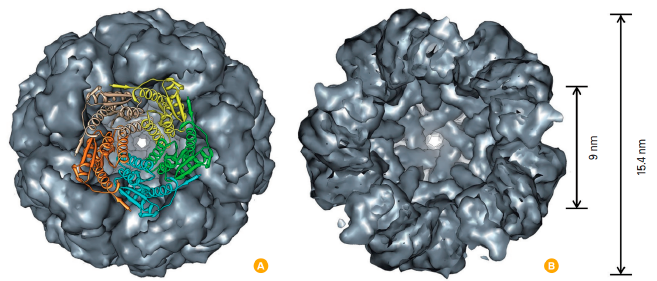
Figure 6. Schematic illustration of lumazine synthase nanoparticle: surface and ribbon diagram (PDB: 1HQK) looking down the five-fold symmetry axis ( A ) and the interior space of the protein cage ( B ). Reproduced with the permission from [138] (CC BY-NC 4.0).